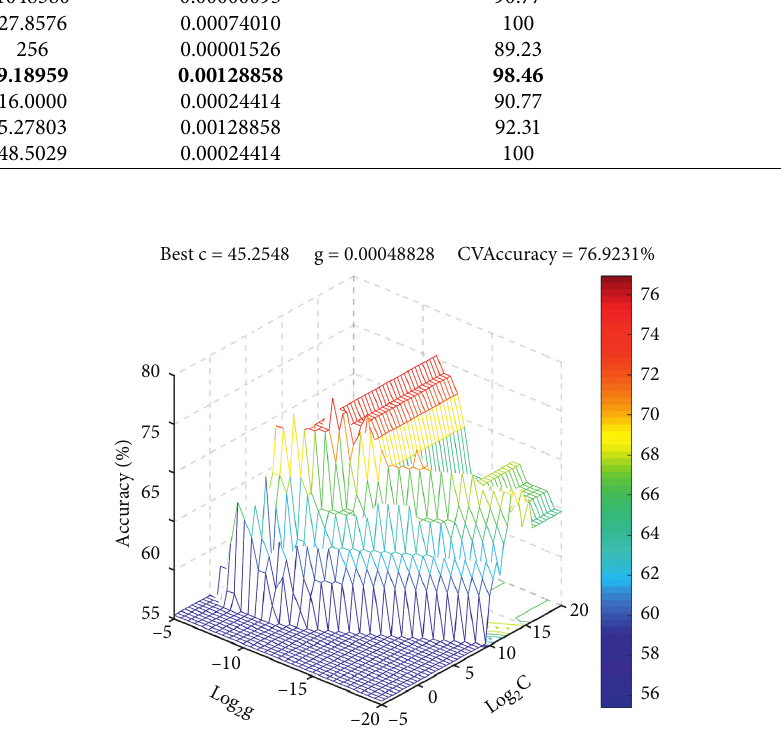
Figure 4: The optimization results for parameters C and g by GS methods with a 10-fold